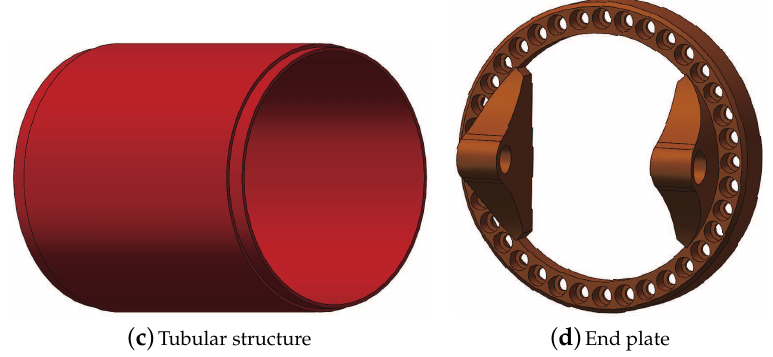
Figure 1. Mechanical design of a cable-driven hyper-redundant manipulator